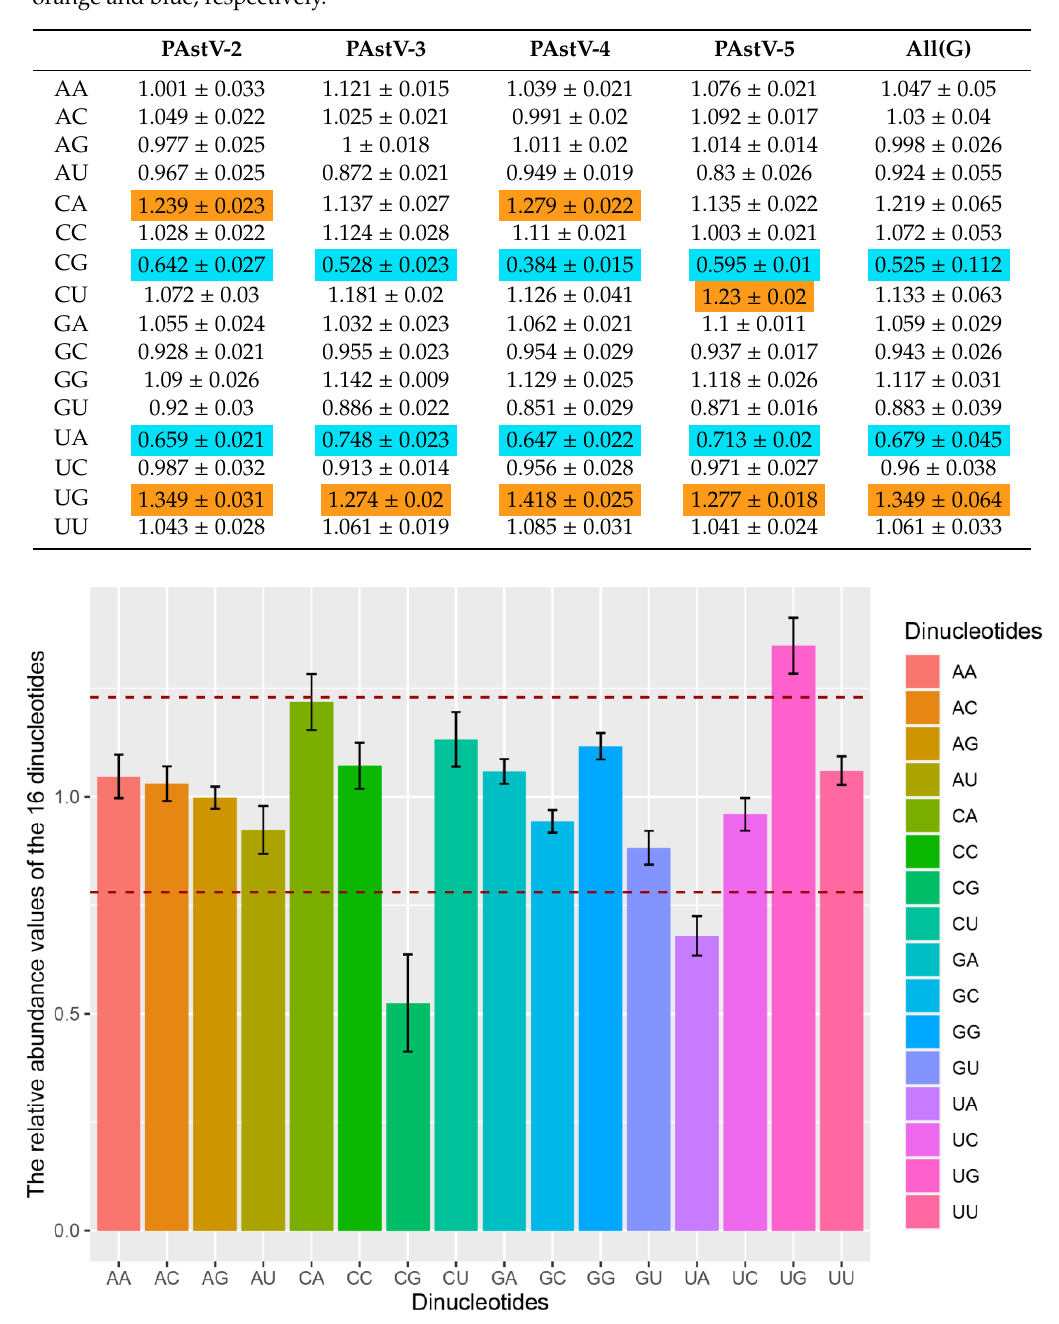
Figure 3. Dinucleotide abundancy of the complete CDS of PAstV. The different colors represent the different dinucleotides. Dinucleotides are regarded as underrepresented or overrepresented if the relative abundance values are below 0.78 or over 1.23 (dashed lines), respectively.